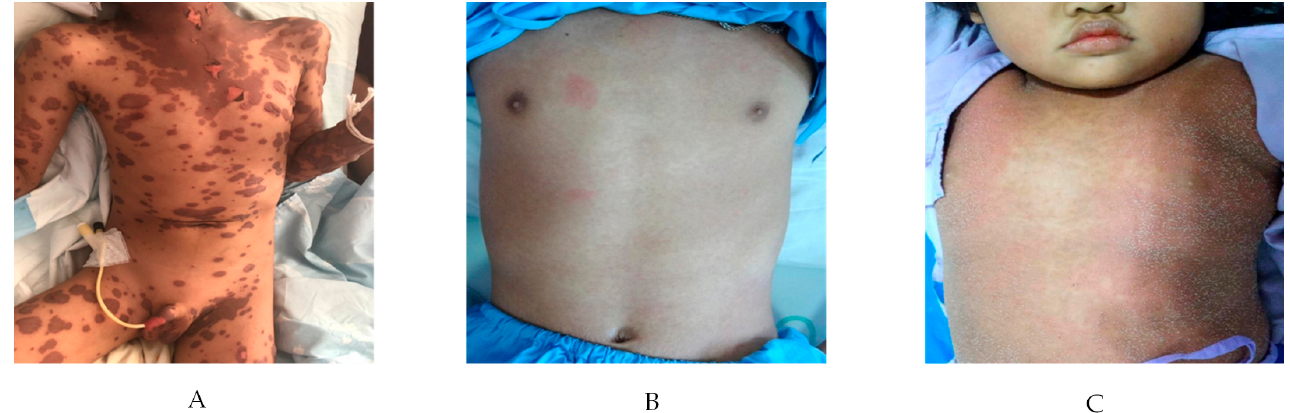
Figure 2. Severe cutaneous adverse drug reactions. ( A ) indicates Stevens–Johnson syndrome (SJS)/toxic Epidermal necrolysis (TEN), ( B ) indicates drug reaction with eosinophilia and systemic symptoms (DRESS) and ( C ) indicates acute generalized exanthematous pustulosis (AGEP).